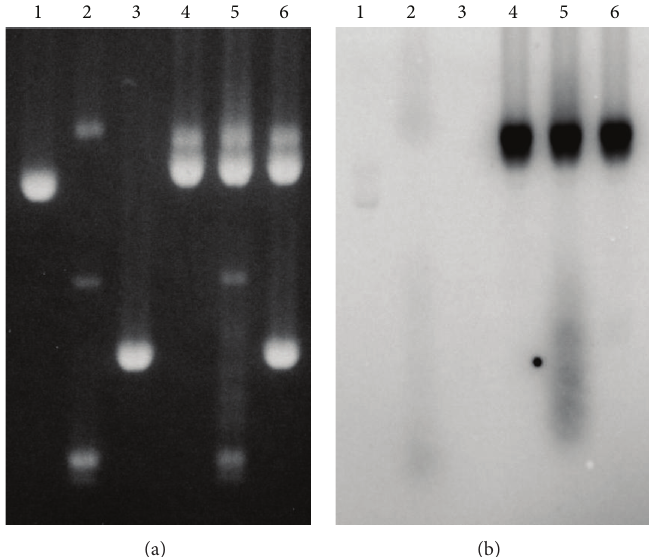
Figure 3: R-loop formation in trans detected by radiolabeling of the transcript. (a) Agarose gel stained with ethidium bromide and (b) autoradiogram of the same gel. Lane 1: pBluescript SK (−) linearized with Xba I; lane 2: supercoiled pHC624-(AGGAG) 22 ; lane 3: pHC624- (AGGAG) 22 linearizedwith Sca I;lane4:pSK-(AGGAG) 22 linearizedwith Xba I;lane5:linearizedpSK-(AGGAG) 22 andsupercoiledpHC624- (AGGAG) 22 ; and lane 6: linearized pSK-(AGGAG) 22 and linearized pHC624-(AGGAG) 22 . All DNAs were incubated in the transcription mixture with T7 RNA